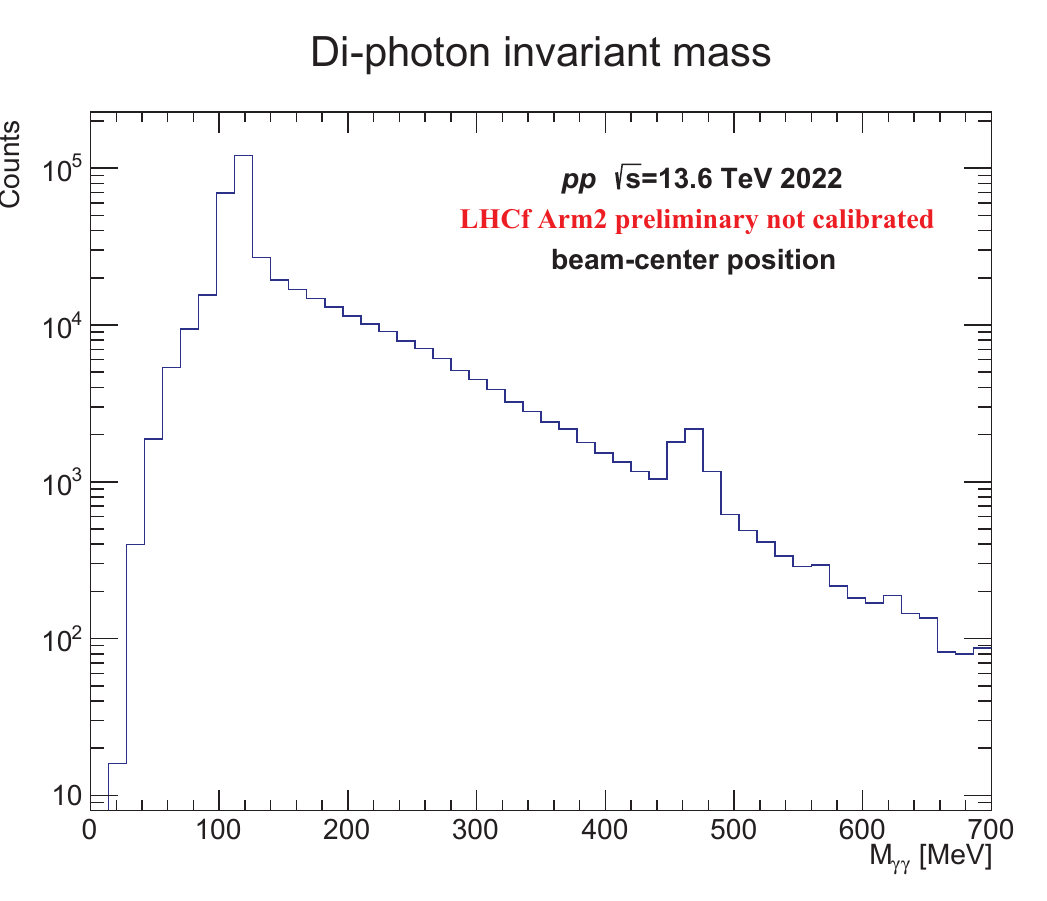
Figure 4. Preliminary invariant mass distribution reconstructed from the two photons for the LHCf-Arm2 detector. A quarter of the total statistics for the beam-center positions were